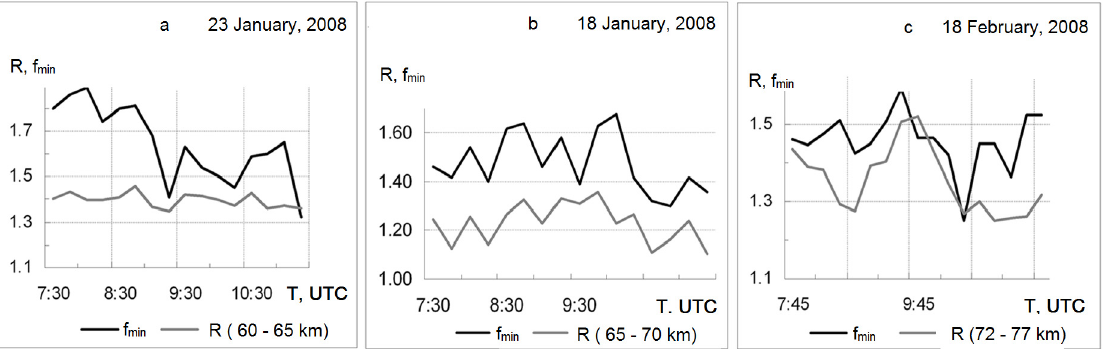
Figure 2. Variations of the layer-averaged scattering ratio R (gray curve) and ionospheric parameter f min (black curve) during different observational intervals: ( a ) on 23 January 2008; ( b ) on 18 January 2008; ( c ) on 19 February 2008 [12].